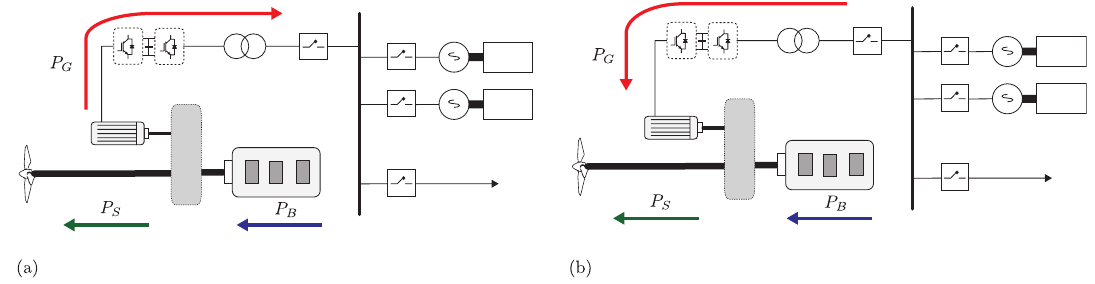
Figure 3. Power flow in ( a ) power take-off operation mode; ( b ) power take-in operation